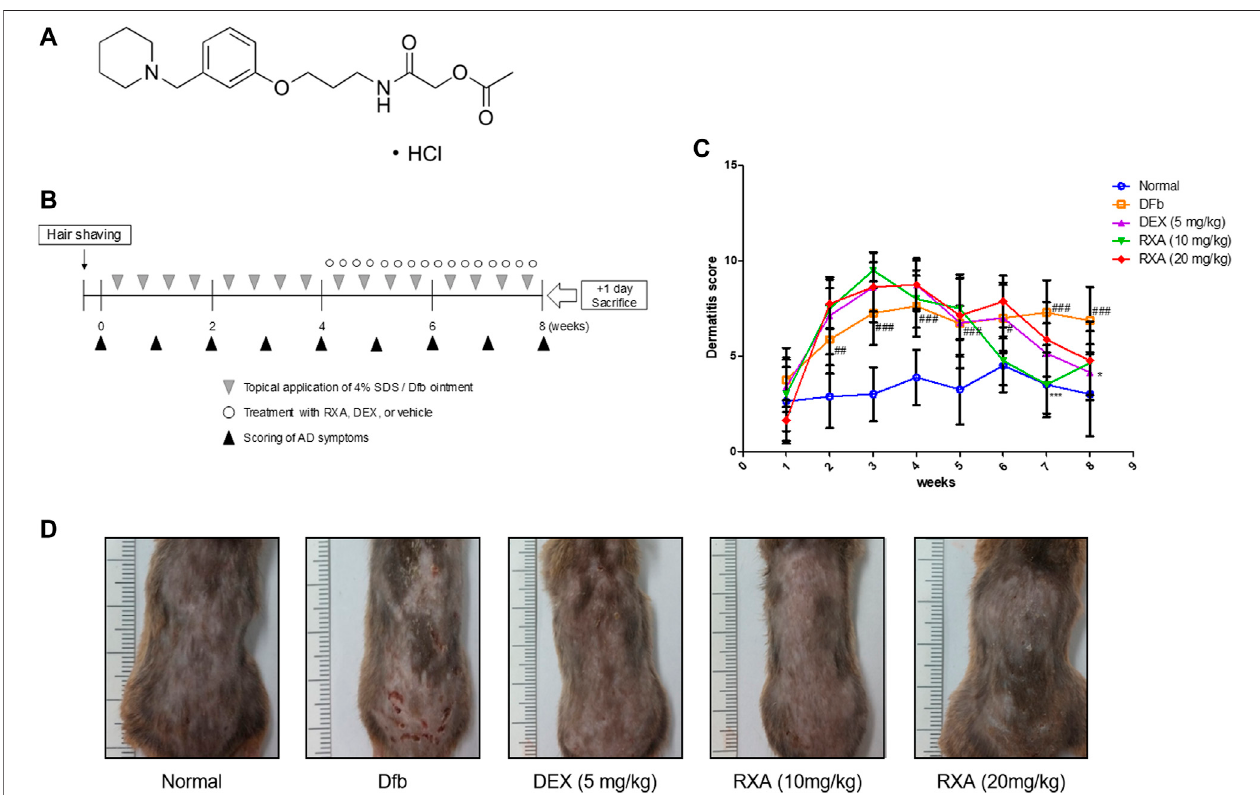
FIGURE1| EffectsofRXAonthedevelopmentofDfb-inducedAD-skinsymptomsinNC/Ngamice. (A) ChemicalstructureofRXA. (B) Schematicrepresentationof theexperiment. (C) ClinicalfeaturesofAD-skinsymptoms. (D) Dermatitis scoresweremeasured onceaweekfor8weeks.Thedermatitis scorewasde fi nedasthesum ofthescoresgraded foreachofthesymptoms.Thedatashownrepresent mean ± S.D.ofthreeindependentexperiments( n (cid:1) 8). # p < 0.05, ## p < 0.01, ### p < 0.001vs. the control group; * p < 0.05, and *** p < 0.001 vs. Dfb-treated group. Dfb, Dermatophagoides farinae